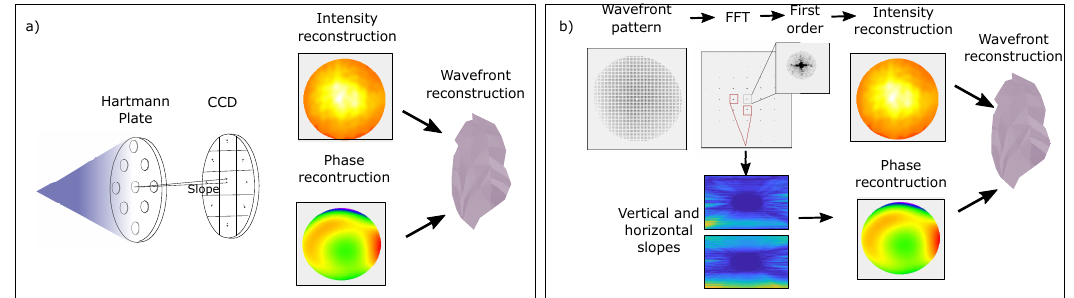
Figure 3. ( a ) Classical centroid method based on measuring relative position change of geometrical center of intensity of each pinhole in Hartmann array to obtain an estimate of the local wavefront slope. ( b ) Fourier demodulation based on the fact that an aberrated wavefront modifies grid periodicity; therefore, the wavefront can be calculated through Fourier transformation. Algorithm has four stages: